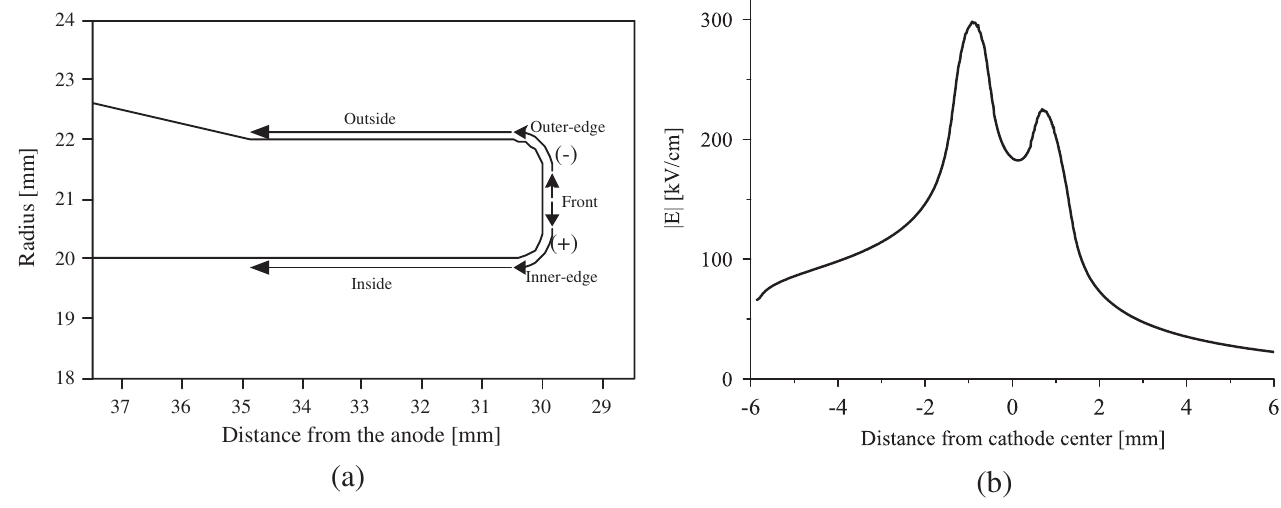
FIG. 4. (a) Cross section of the cathode. (b) The magnitude of the electric field at the cathode tip obtained with the Poisson code. The horizontal axis represents the distance along the vertical line at 0.01 mm from the cathode front. The A-K gap voltage is 140 kV. The cathode edge was rounded to 0.5 mm in radius which is the same as the real model.